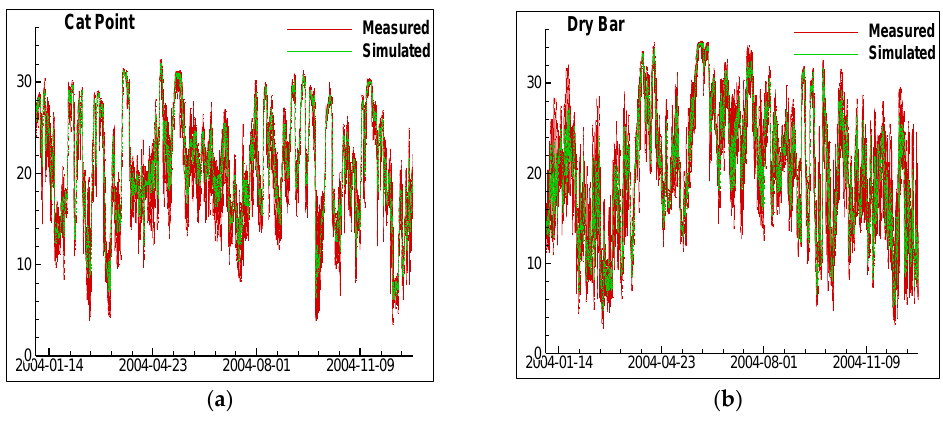
Figure 4. Simulated salinity at ( a ) Cat Point; and ( b ) Dry Bar stations during 2004.